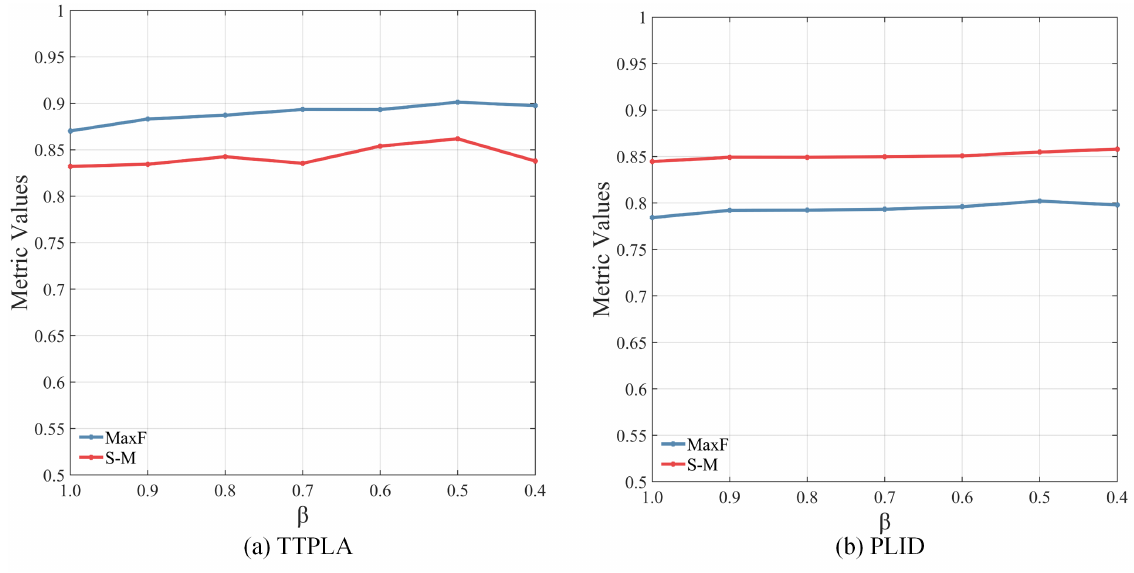
Figure 8. Analysis of the power line detection method performance effected by different values of β